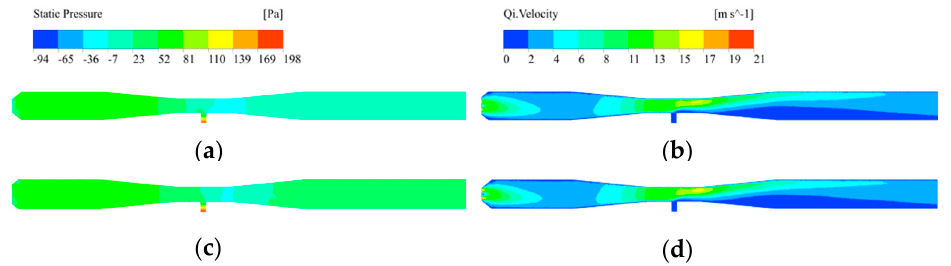
Figure 4. The distribution nephogram of the pressure and velocity in the reactor: ( a ) pressure distribution without the addition of citric acid, ( b ) velocity distribution without the addition of citric acid, ( c ) pressure distribution with the addition of citric acid, and ( d ) velocity distribution without the addition of citric acid.